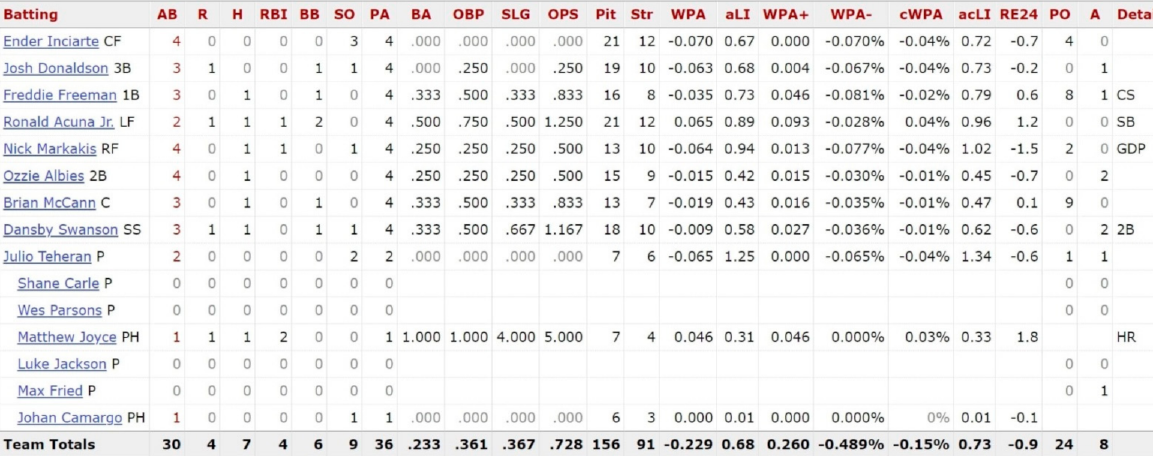
Figure 2. Atlanta Braves batting statistics.